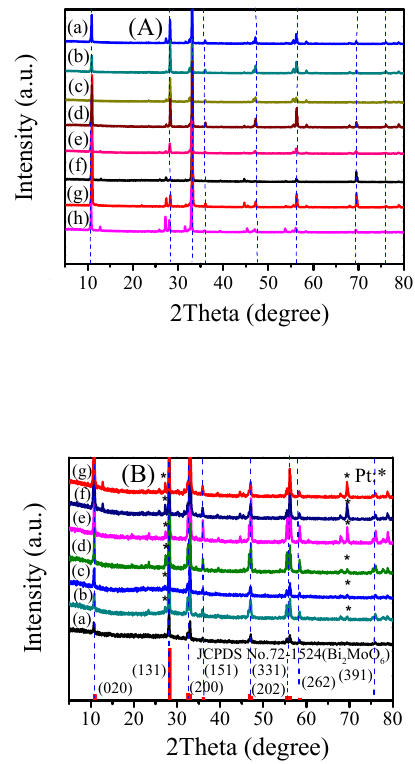
Figure 1. ( A ) XRD patterns of di ff erent catalysts: ( a – c ) γ -Bi 2 MoO 6 (ethylene glycol method, nitric acid method, and glacial acetic method, pH = 9, 180 ◦ C), ( d – e ) γ -Bi 2 MoO 6 (nitric acid method, pH = 9, 150 ◦ C, and 130 ◦ C), ( f – h ) γ -Bi 2 MoO 6 (nitric acid method, pH = 8, 10, and 11, 180 ◦ C). ( B ) XRD patterns of di ff erent catalysts: ( a ) γ -Bi 2 MoO 6 (nitric acid method, pH = 9, 180 ◦ C), ( b – f ) 1 wt %, 2 wt %, 3 wt %, 4 wt %, and 5 wt % Pt / γ -Bi 2 Mo 6 (nitric acid method, pH = 9, 180 ◦ C), and ( g ) recycled 4 wt % Pt / γ -Bi 2 MoO 6 (nitric acid method, pH = 9, 180 ◦